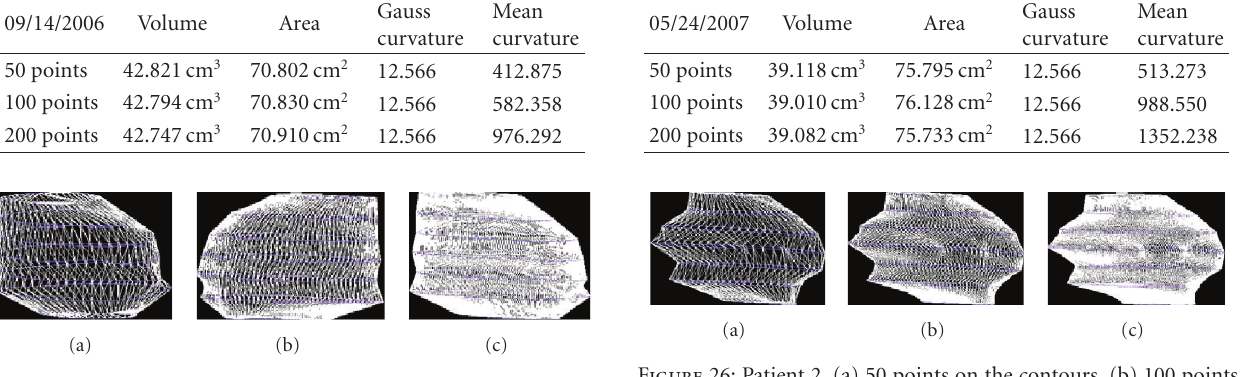
Figure 24: Patient 2. (a) 50 points on the contours, (b) 100 points on the contours, and (c) 200 points on the contours.